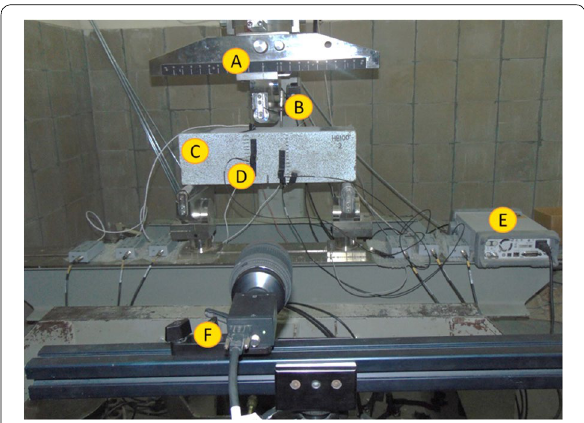
Fig. 2 Fracture test setup: a loading beam; b displacement sensor; c notched specimen; d AE sensors; e wave actuator; f